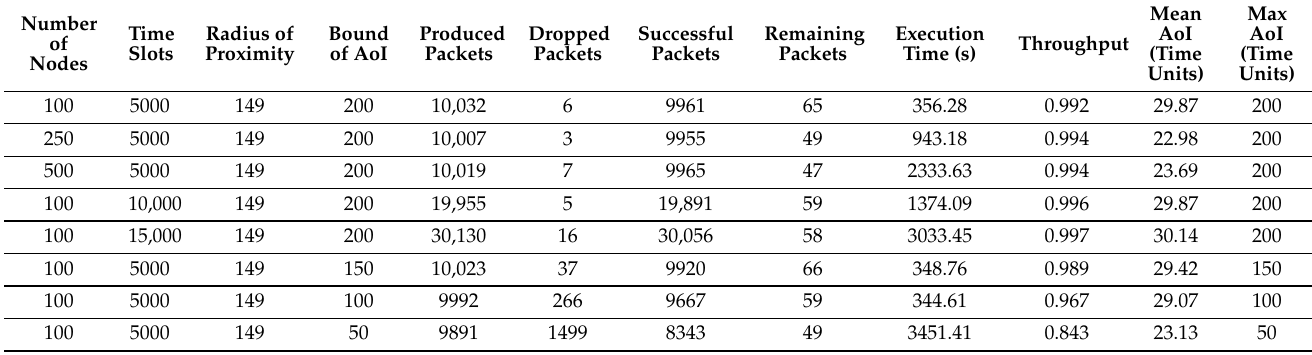
Table 8. Larger scale simulation for